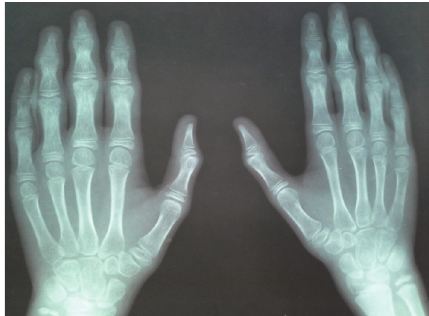
Figure 3: X-ray of hands showing epiphyseal enlargement of the metacarpophalangeal and interphalangeal joints with juxta- articular osteopenia.